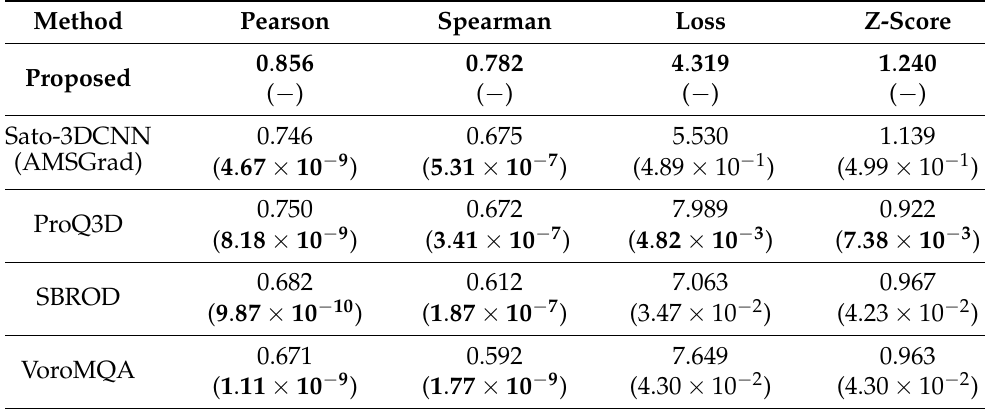
Table 3. Performance in the CASP12 stage 2 test